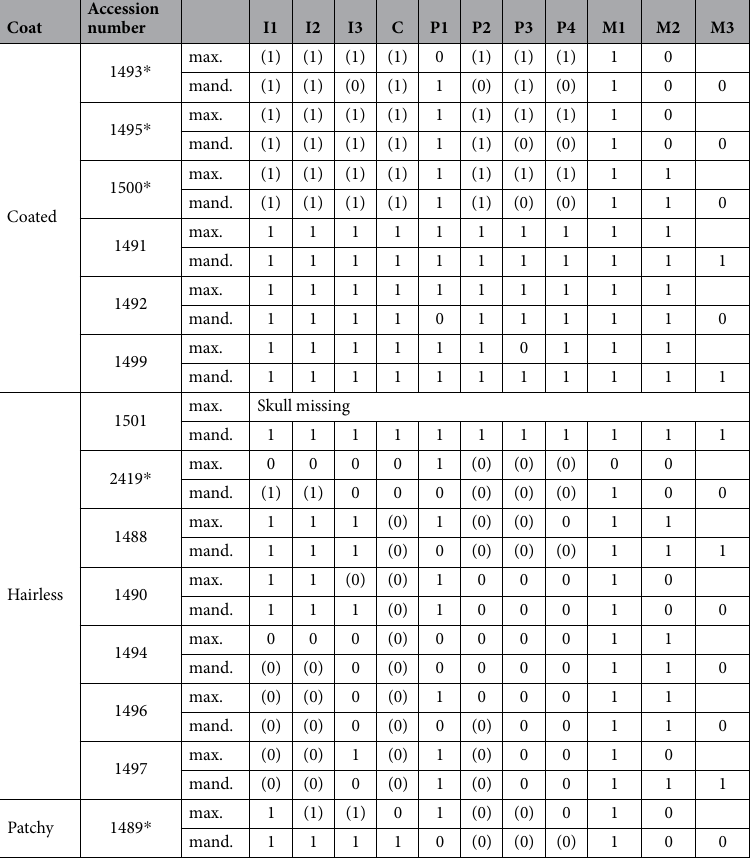
Patchy Table 2. Dental status (maxillary and mandibular) in coated and hairless dog sample. Presence and absence of deciduous and permanent teeth indicated by the following codes: 1 = fully developed permanent tooth or molar; (1) deciduous tooth and developing permanent tooth or molar; 0 = missing deciduous or permanent tooth; (0) = retained deciduous tooth and missing permanent tooth; max. = maxillary; mand. = mandibular. * Juveniles with mixed deciduous and developing permanent